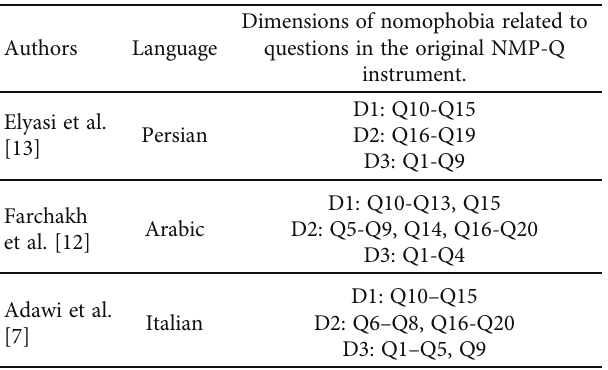
Table 2: Previous work in which three dimensions were found for measuring nomophobia.